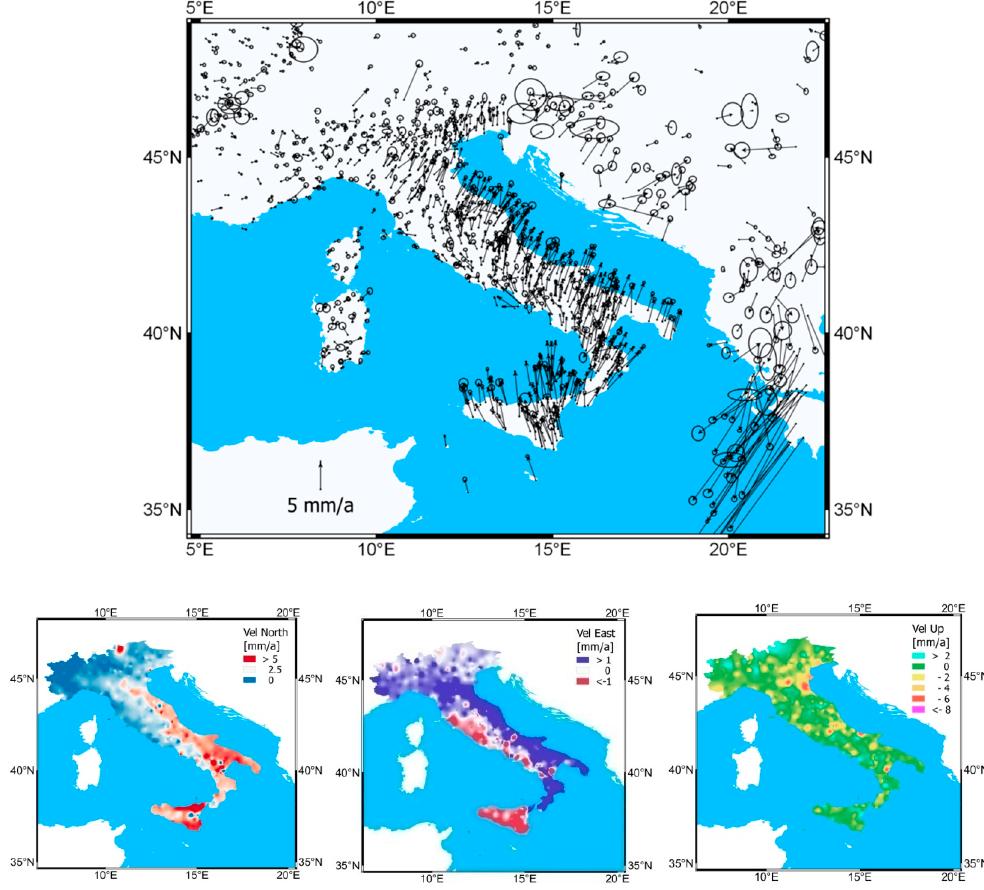
Figure 2. Top —Horizontal velocity residuals with respect to the European reference system (ETRS89) and their uncertainty ellipses at 95% confidence level. The map shows also GNSS velocities of the sites displaced around the study area. Bottom —Map of single components (North, East, Vertical) of ground surface velocity derived by GNSS permanent stations of the study area.